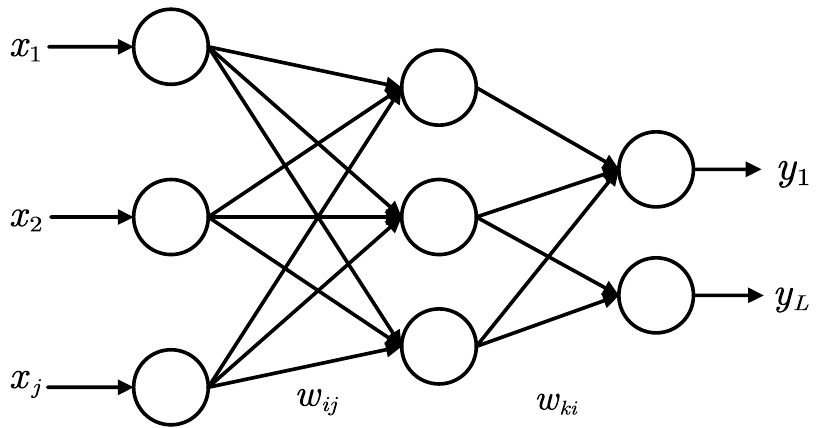
Figure 2. Topological structure of a typical back propagation neural network. BP neural network consisted of input variables X = ( x 1 , x 2 , . . . , x m ) , hidden layers q and output nodes Y = ( y 1 , y 2 , . . . , y m )